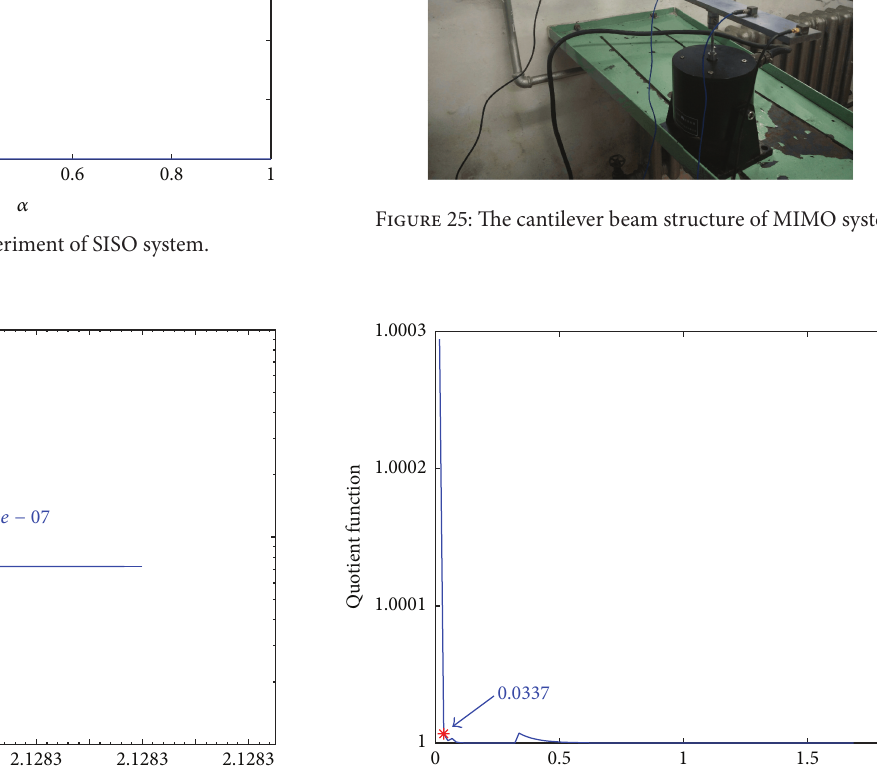
Figure 23: L -curve in experiment of SISO system.